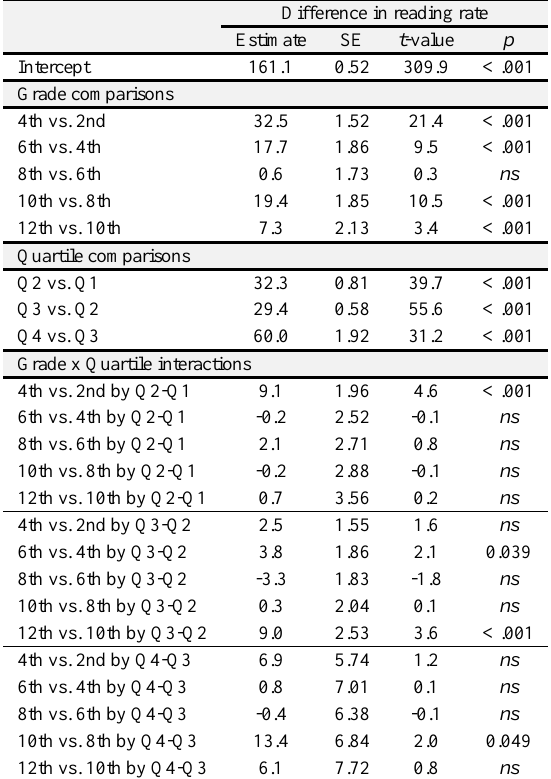
Table 3. Differences in Reading Rate Between Grades and Reading Rate Quartiles Difference in reading rate Estimate SE t -value Intercept